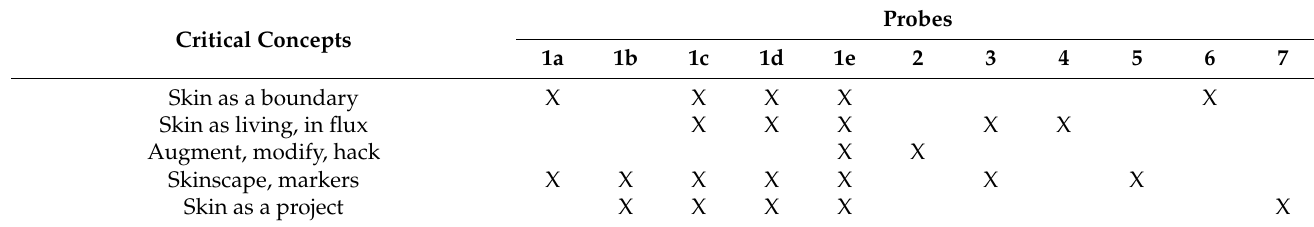
Table 1. Mapping of the four critical concepts to the interactive skin